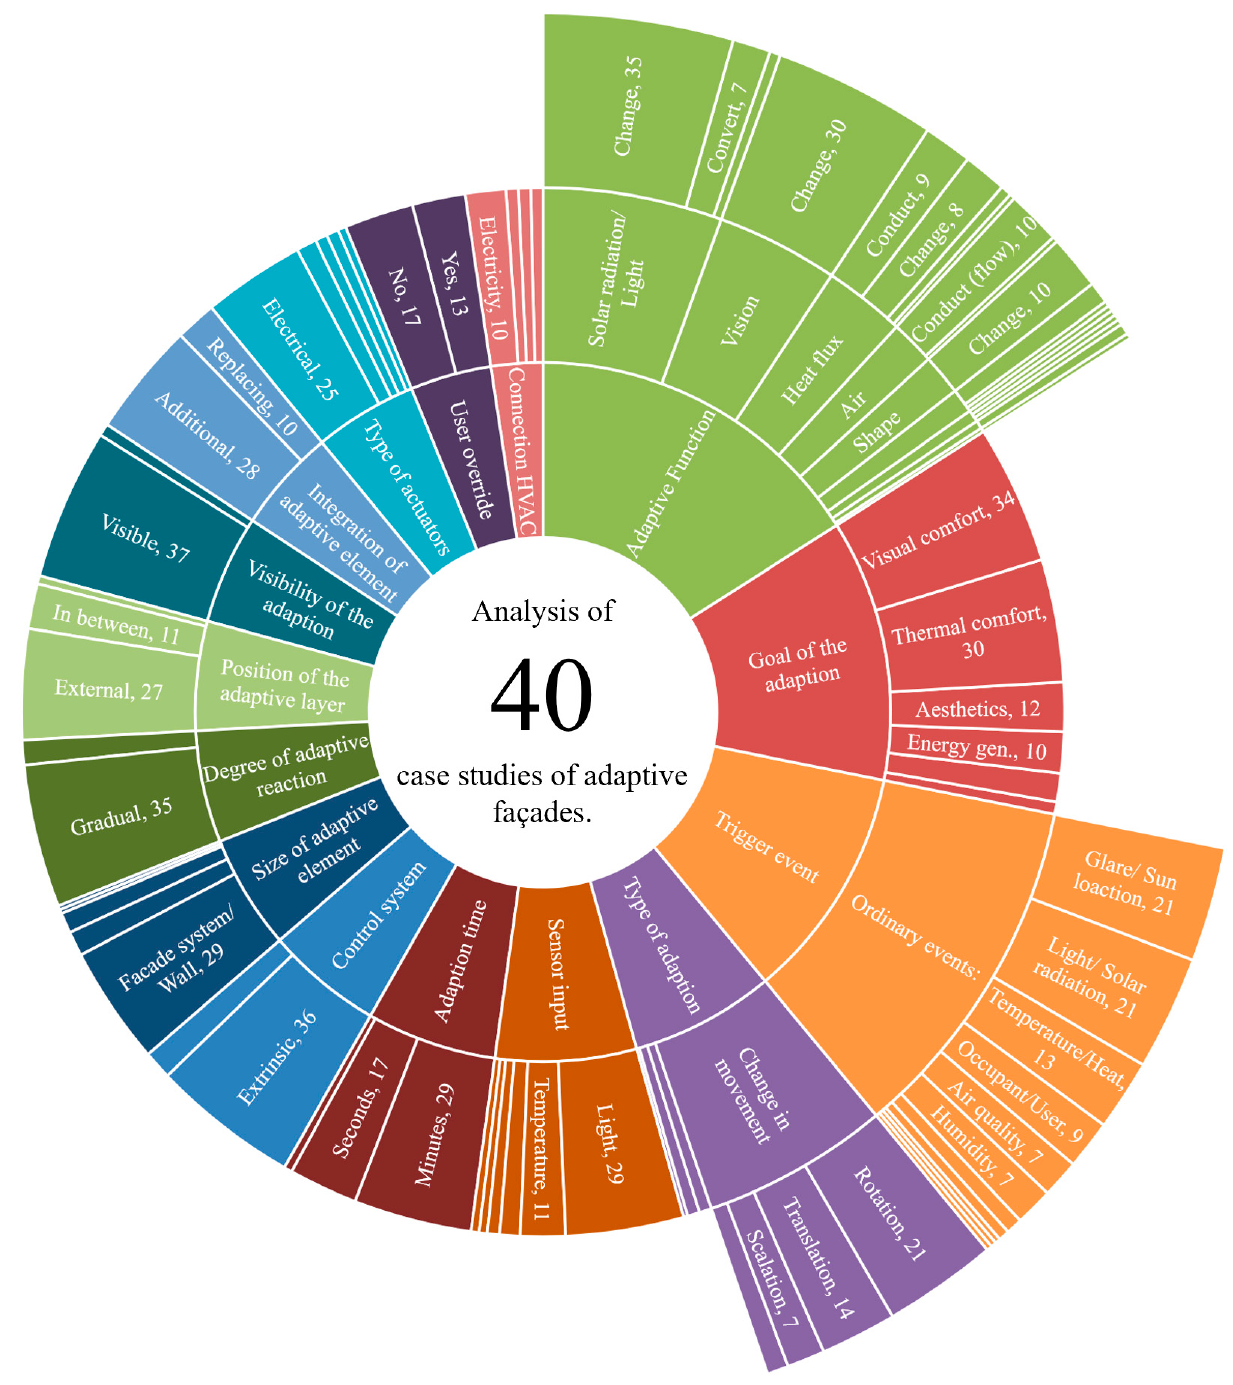
Figure 17. Assigning 40 AF case studies to the design parameters (sorted by frequency), from [24].